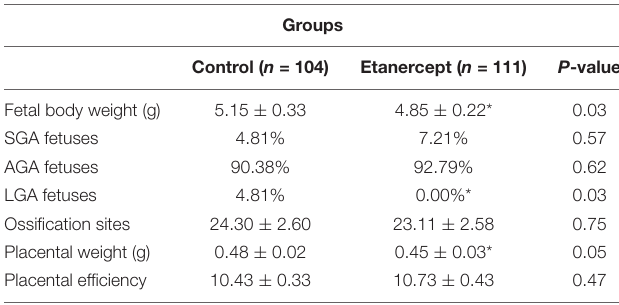
TABLE 2 | Fetal and placental development and placental efficiency of control and etanercept-treated rats at term of pregnancy (day 21 of pregnancy). Groups